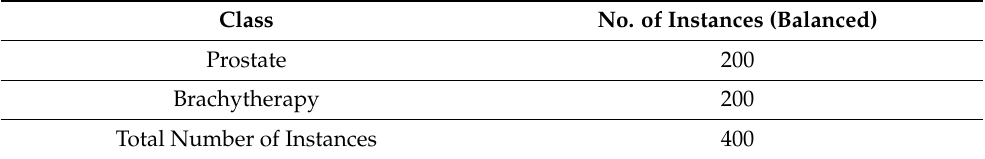
Table 1. Dataset